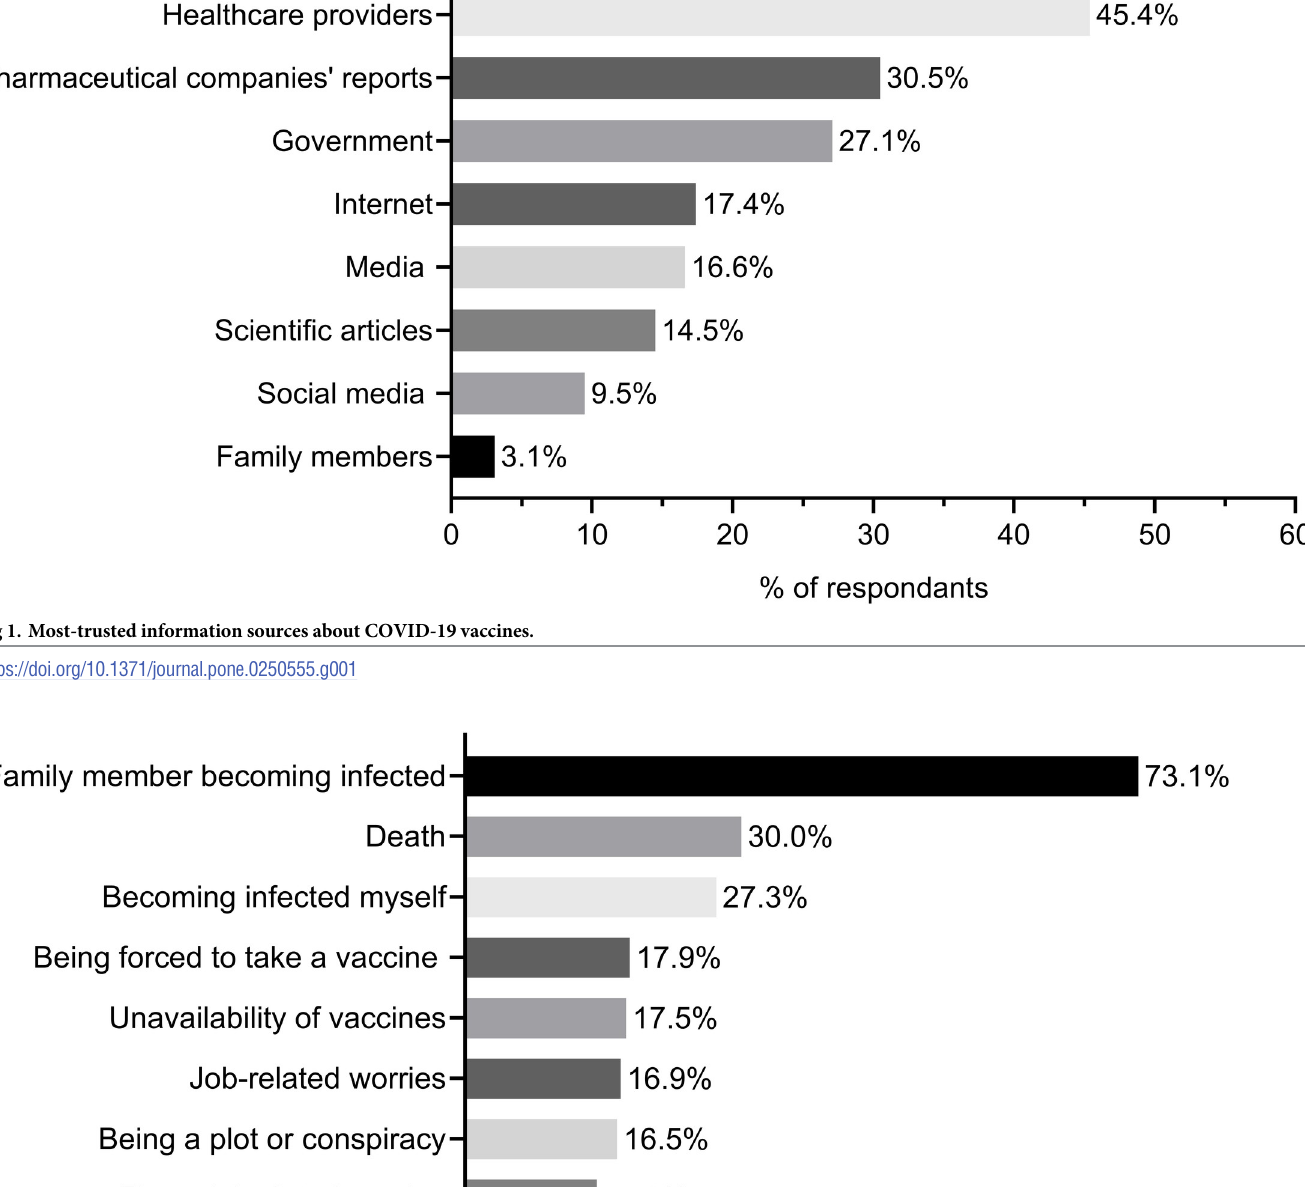
PLOS ONE | https://doi.org/10.1371/journal.pone.0250555 April 23,